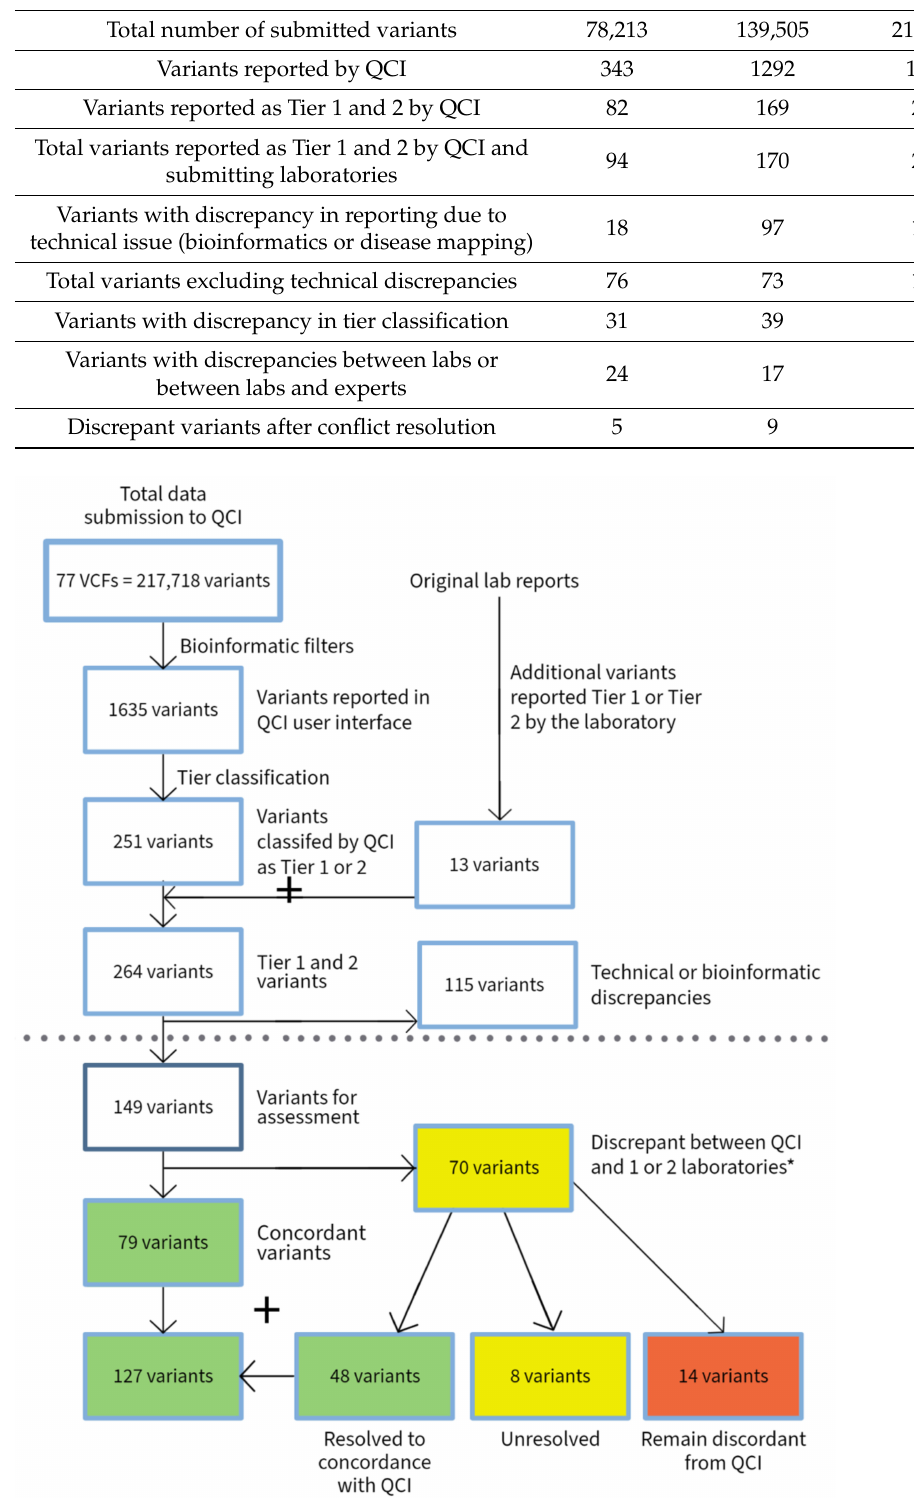
Figure 1. Flow diagram of summary data. * Discrepancy between laboratories 1 and 2 may indicate agreement with QCI from at least one